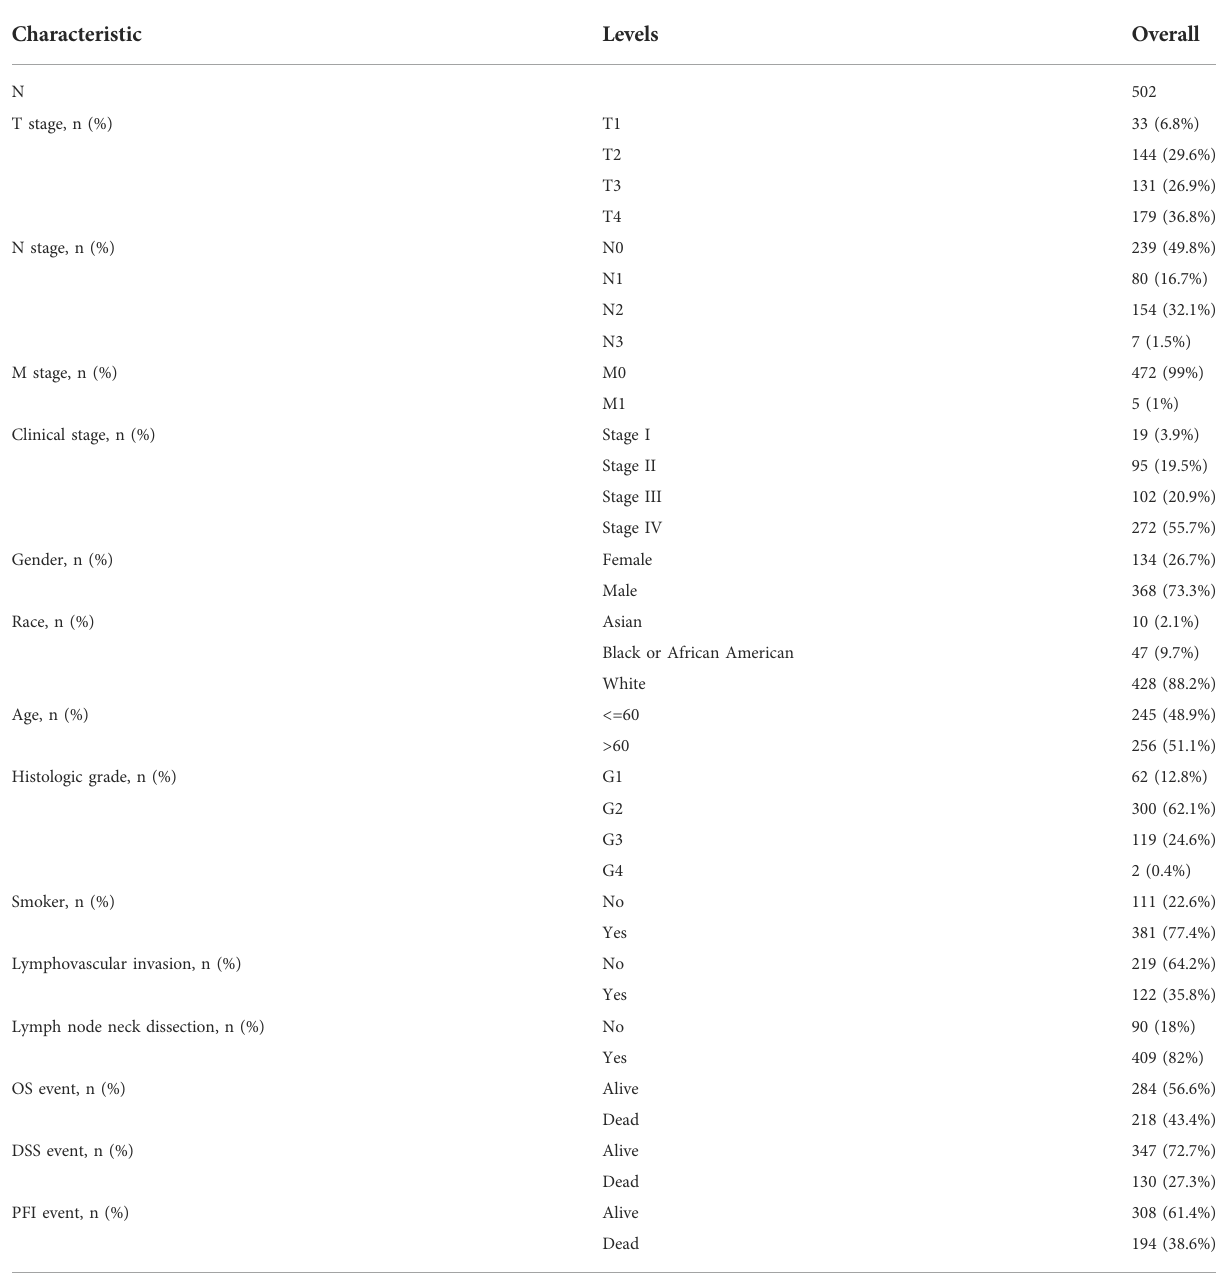
TABLE 1 Clinical characteristics of the HNSC patients (from TCGA).